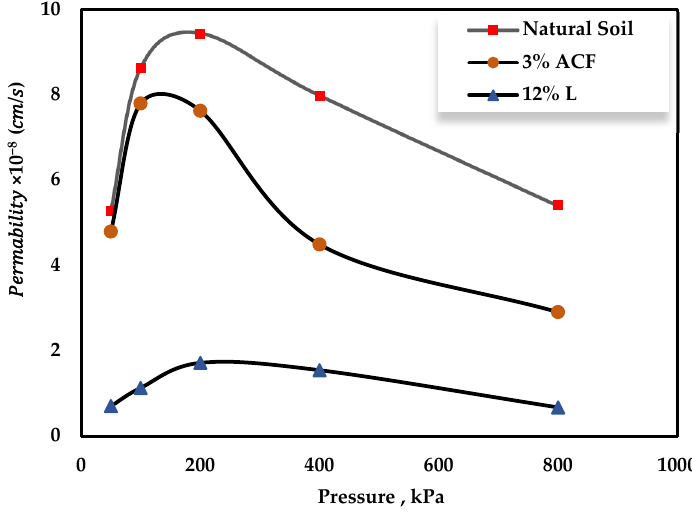
Figure 11. Permeability coefficient.